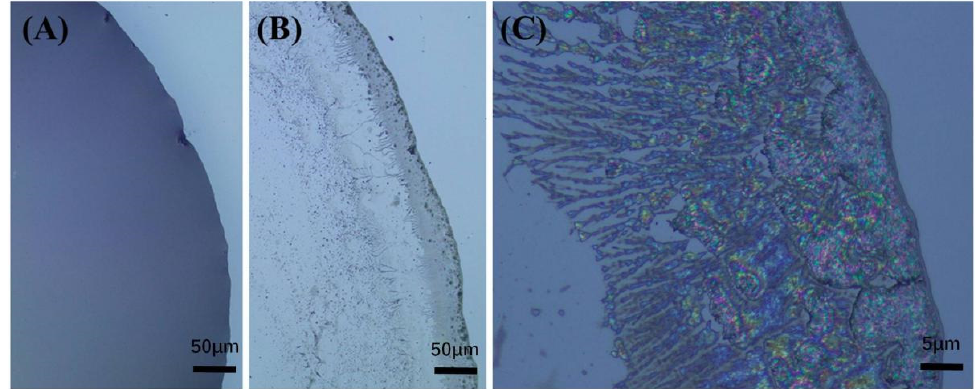
Figure 7. Polarizing optical microscope (POM) images of 0.05 wt% CS-TA-Na water dispersion self-assembled at 60 °C with the lapse of time: ( A ) 0 s, ( B ) 60 s, ( C ) enlarged view of ( B ).